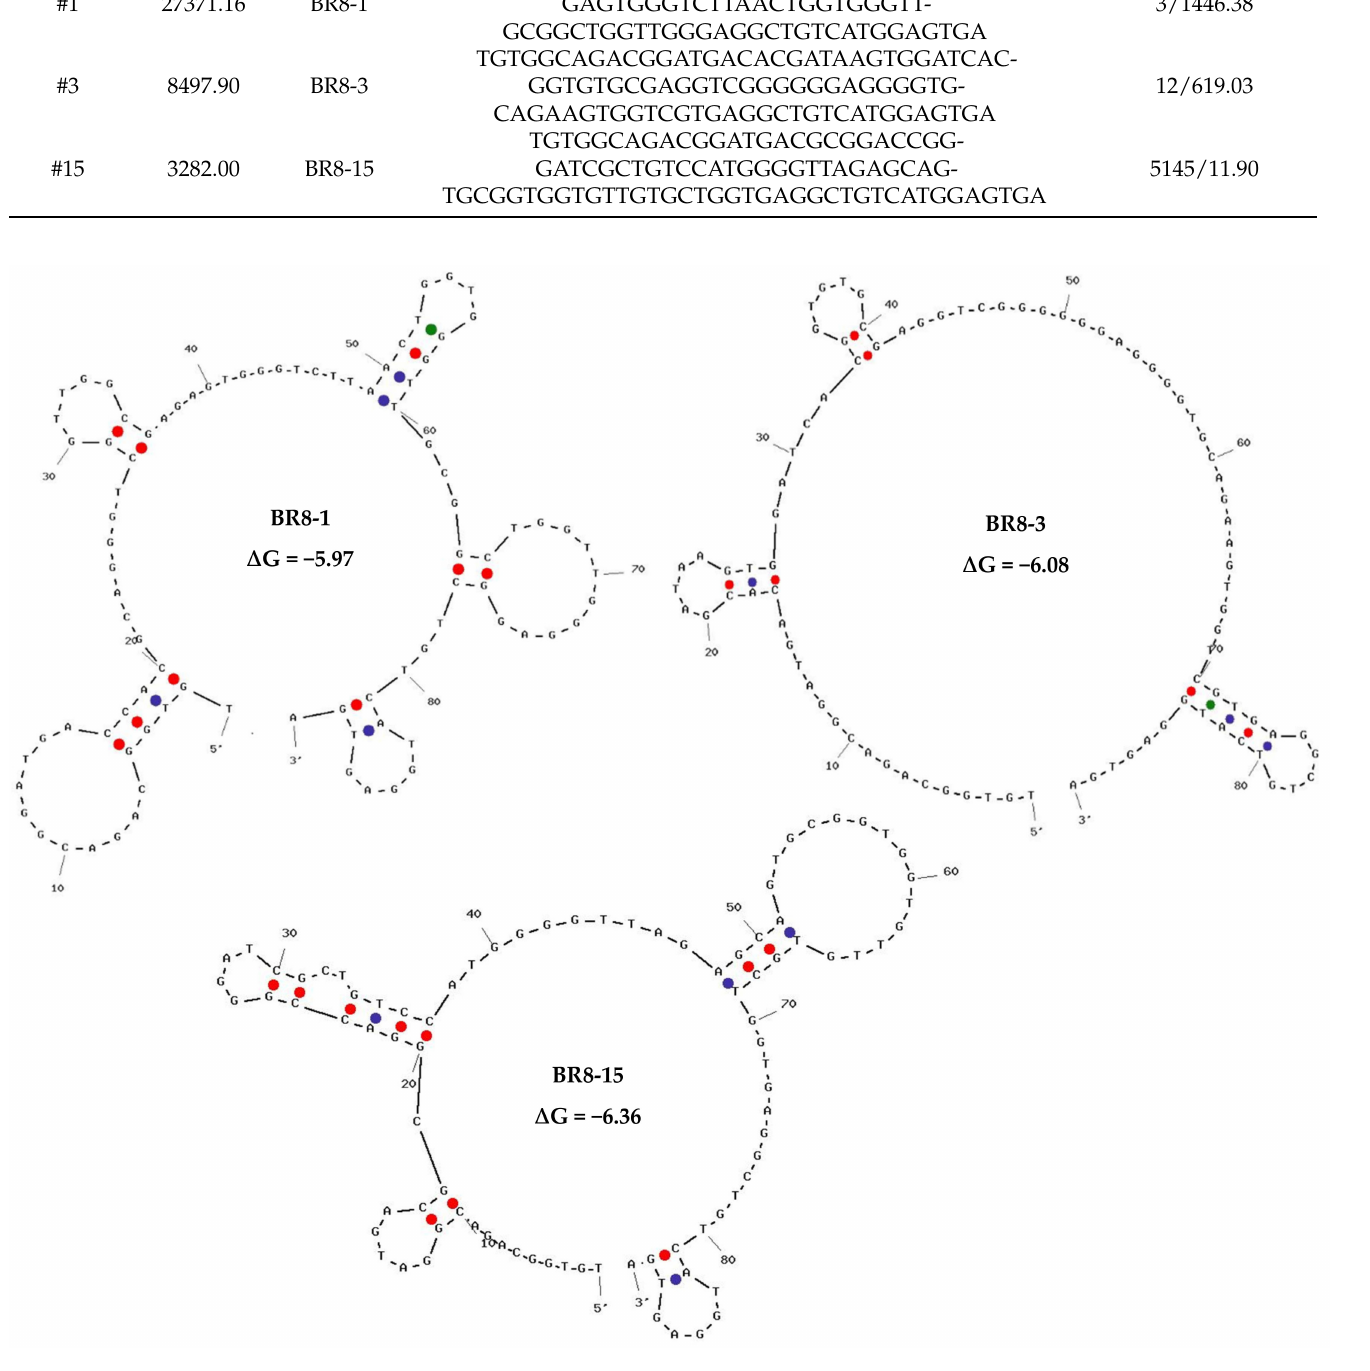
Figure 2. Secondary structure prediction and minimal free energy calculation for the selected aptamers using the UNAFold tool,